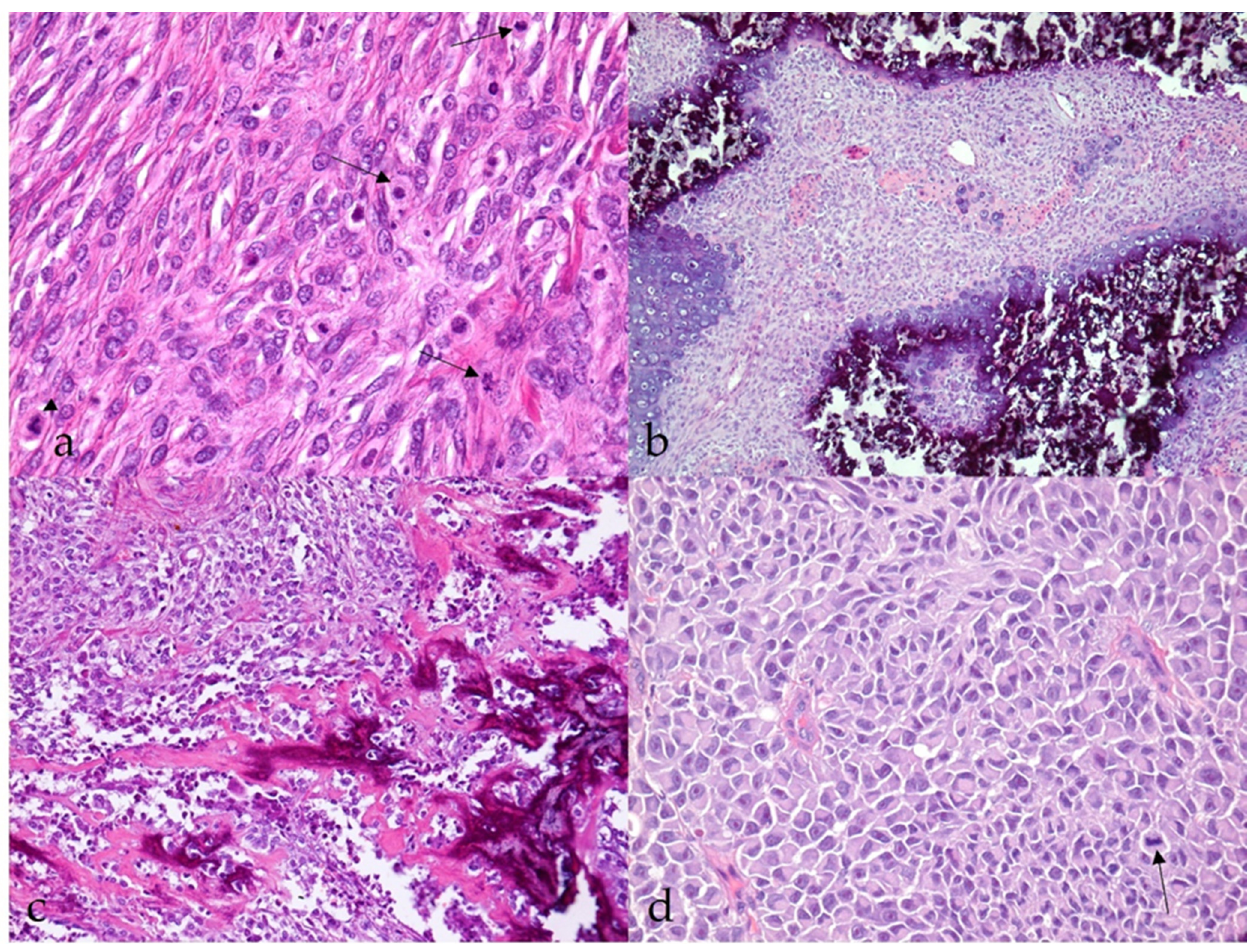
Figure 4. Histopathological characteristics of malignant nerve sheath tumors (MNSTs). ( a ) Brisk mitotic activity; few mitoses are indicated by an arrow. Occasionally, atypical mitoses are seen (arrowhead) (case no. 53). HE, 400 × . ( b ) Chondrosarcomatous differentiation of MNST (case no. 78). HE, 100 × . ( c ) Osteosarcomatous differentiation of MNST (case no. 39). HE, 100 × . ( d ) Epithelioid MNST. The arrow indicates mitosis (case no. 79). HE, 400 ×